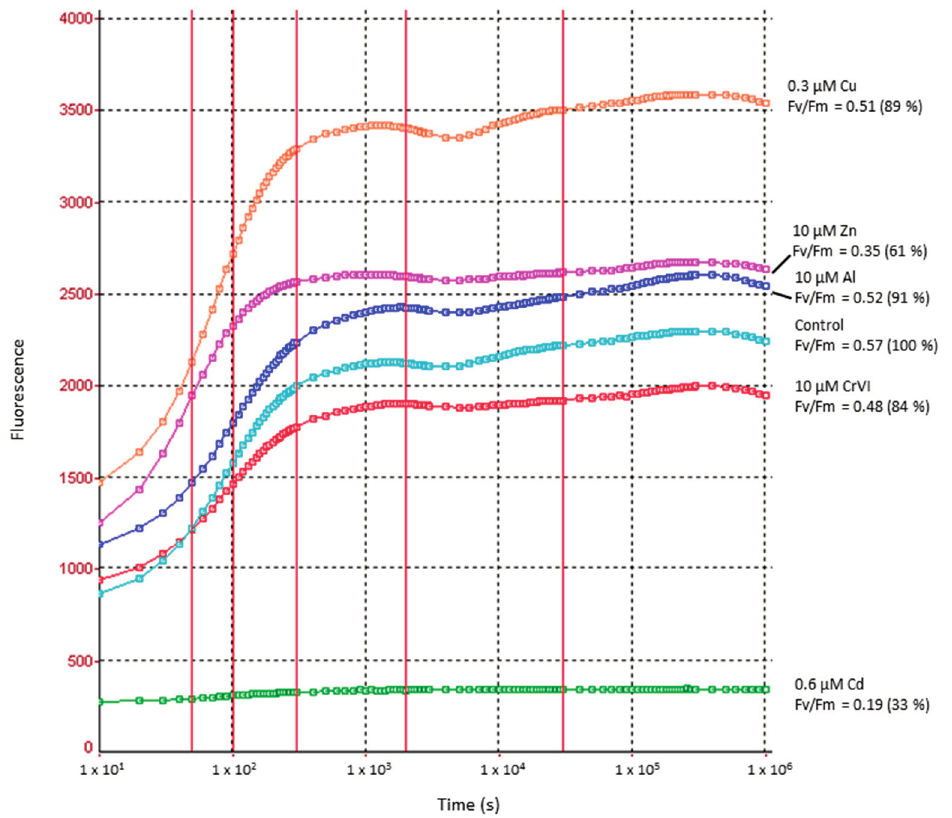
Figure 5. Photosynthetic electron transport efficiency in PSII in controls and heavy metal treated Desmidium filaments after 21 days measured by fast chlorophyll